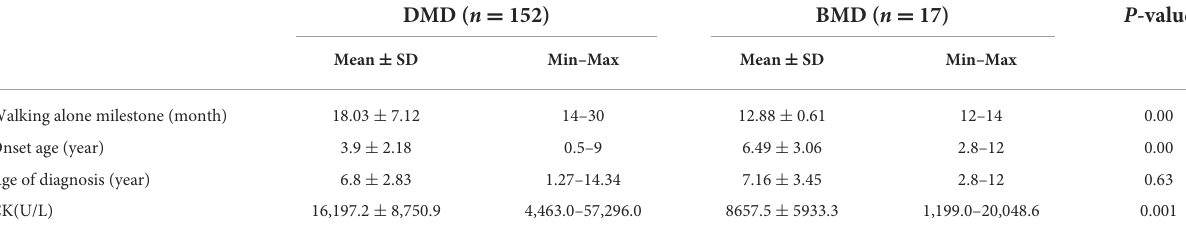
TABLE 1 Clinical manifestations and investigations of DMD and BMD cases.